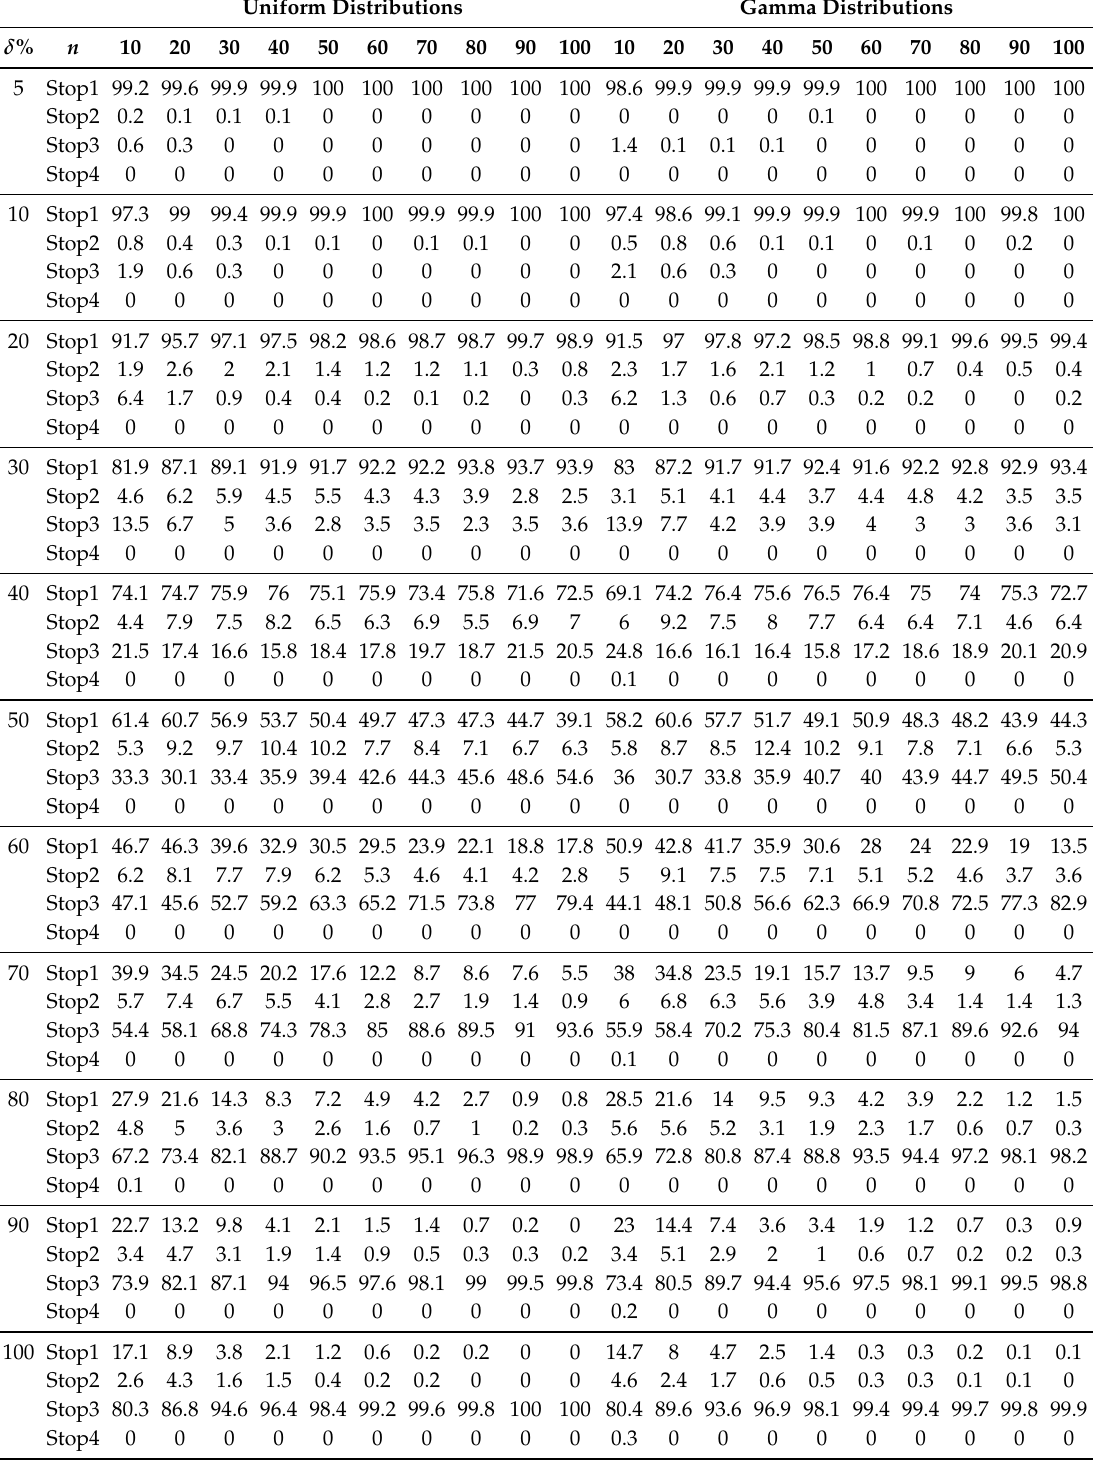
Table A3. Computational results for randomly generated instances with the ratio 0%:0%:30%:70% of the numbers of jobs in the subsets J 1 , J 2 , J 1,2 and J 2,1 of the job set J